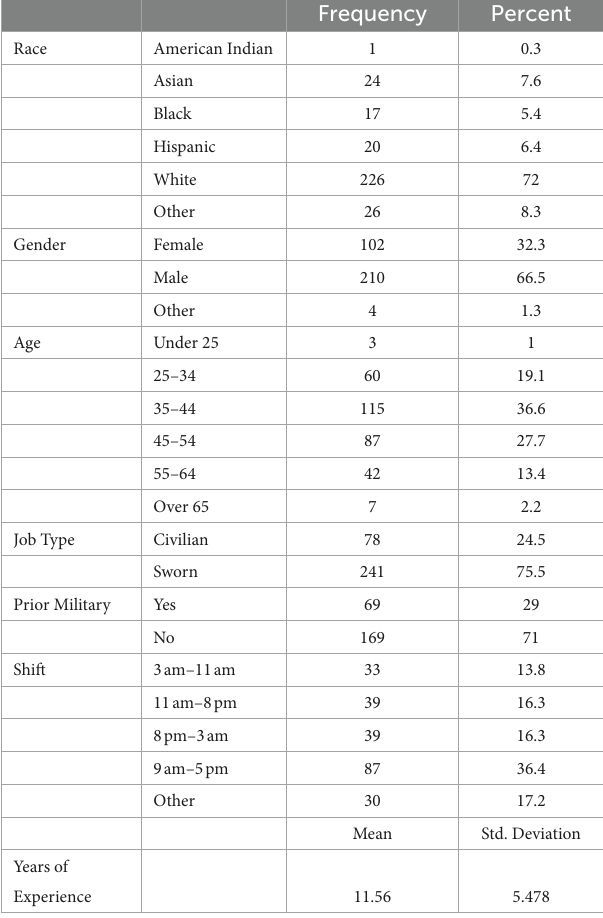
TABLE 1 Characteristics of the sample ( N =